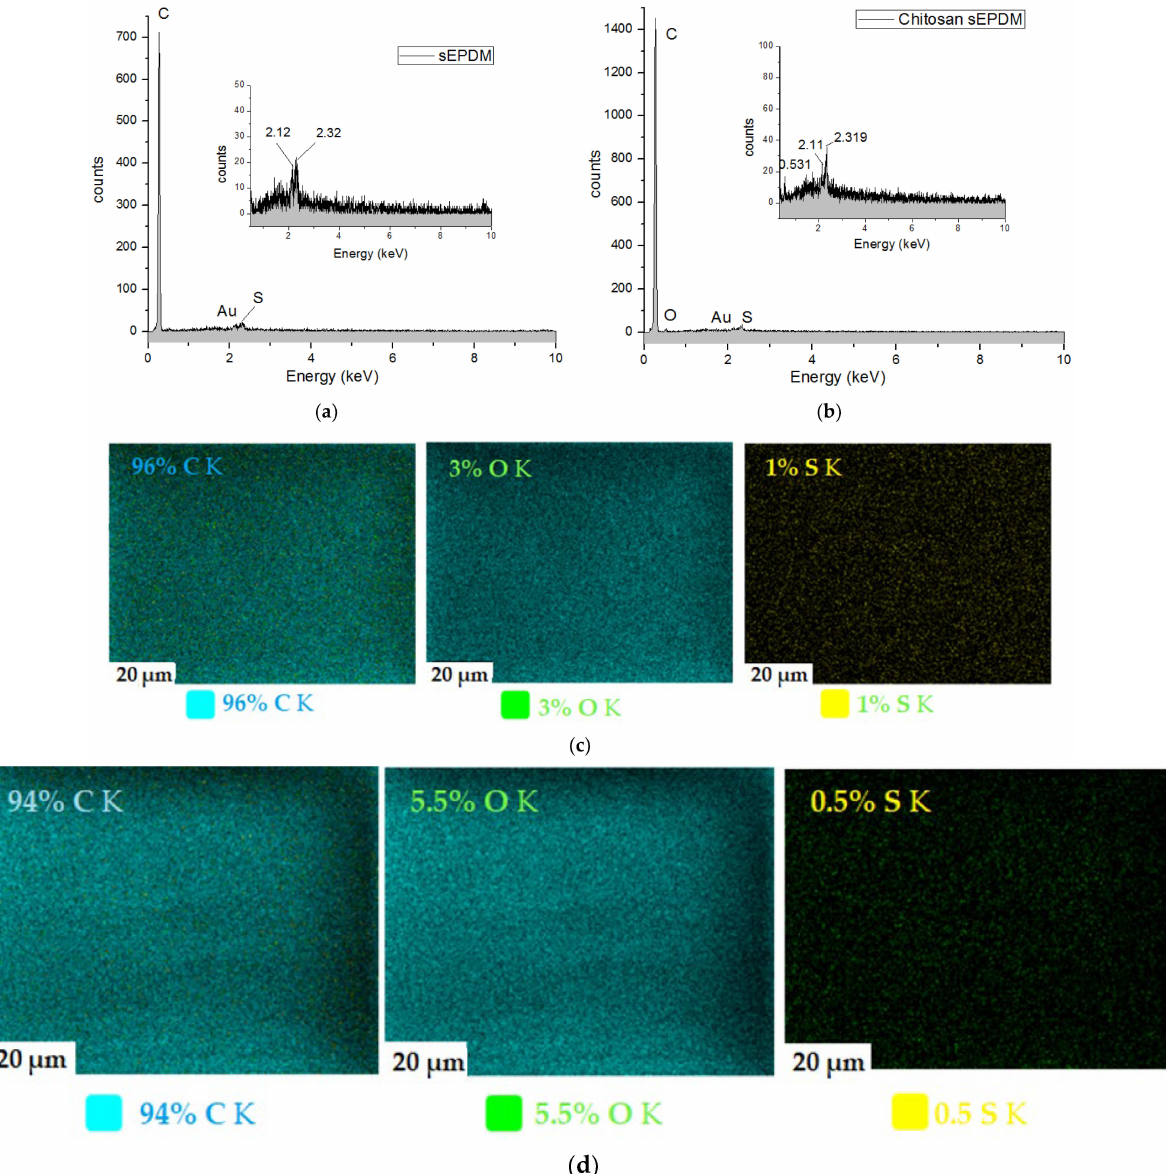
Figure 6. Energy-dispersive spectroscopy analysis (EDAX) diagram for the membrane materials: sEPDM ( a ); Chi/sEPDM ( b ); and elemental maps: sEPDM ( c ); Chi/sEPDM ( d